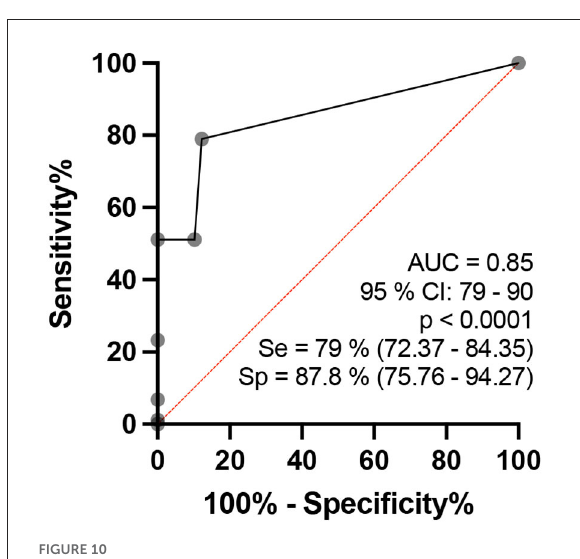
FIGURE10 ROC curve analysis of the percentages of the number of asymmetries of the neural sites assessed per individual, which is considered to be altered ( 1 CSA > 2.5 mm 2 ) when comparing the healthy and HD groups in the age range of 15 to 60 years.